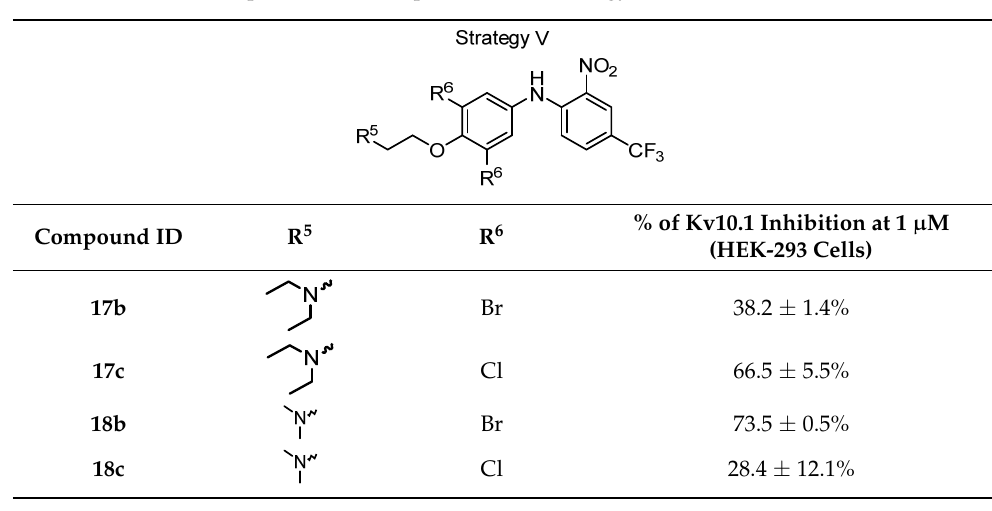
− 2.1 ± 5.7% Table 3. Structures and potencies of compounds from Strategy III. Compound ID